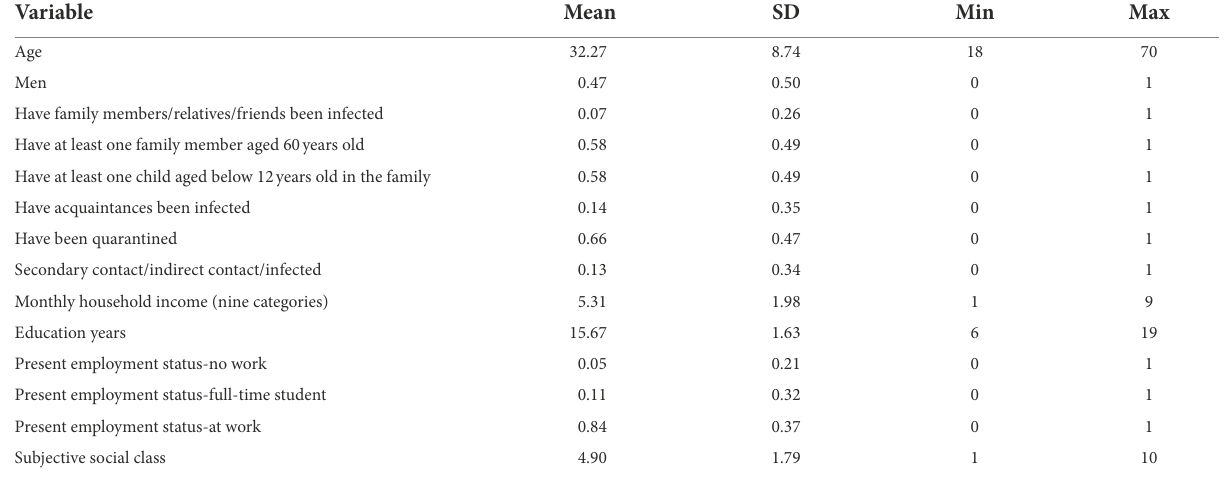
TABLE 1 Sample characteristics ( N =